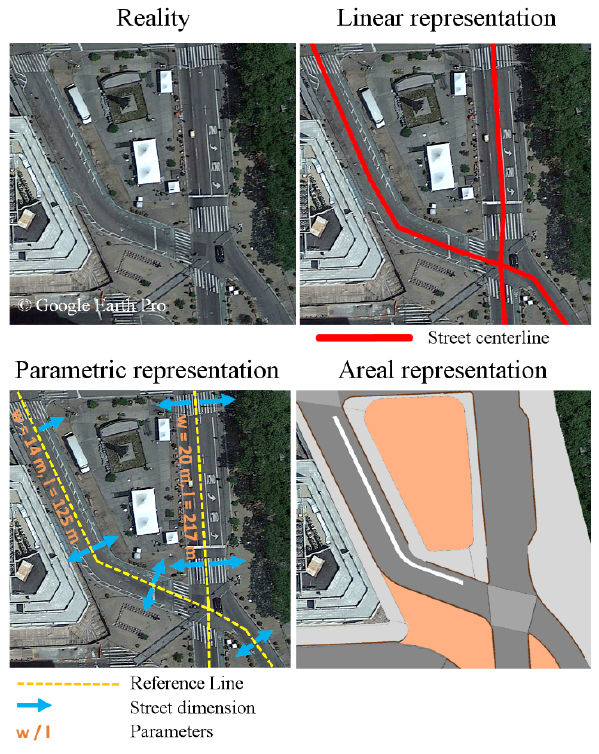
Figure 1. Comparison of different representation